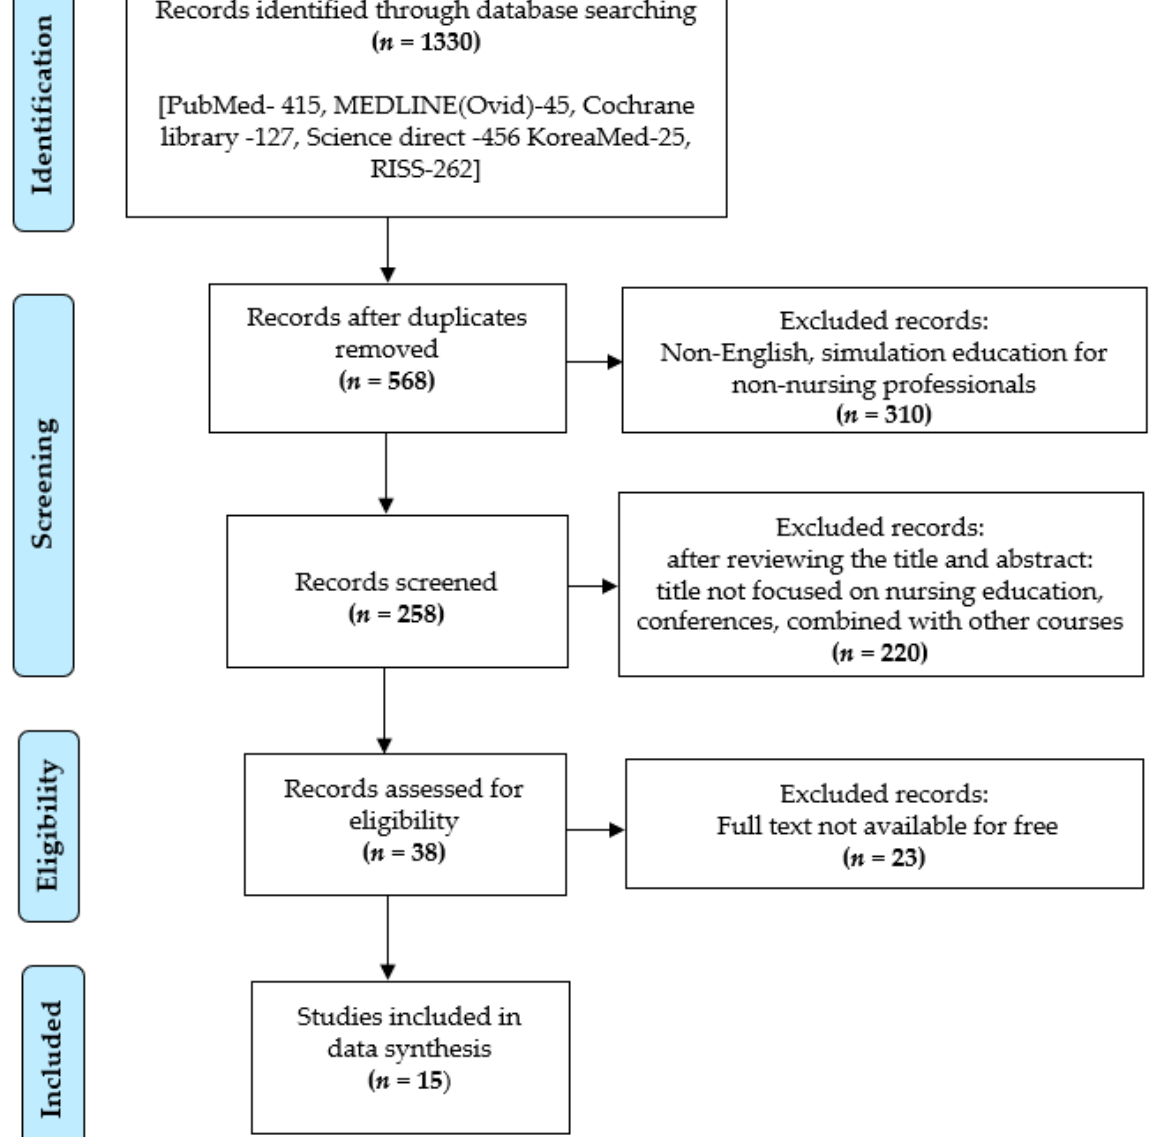
Figure 1. Flow chart for the literature search and article selection process.